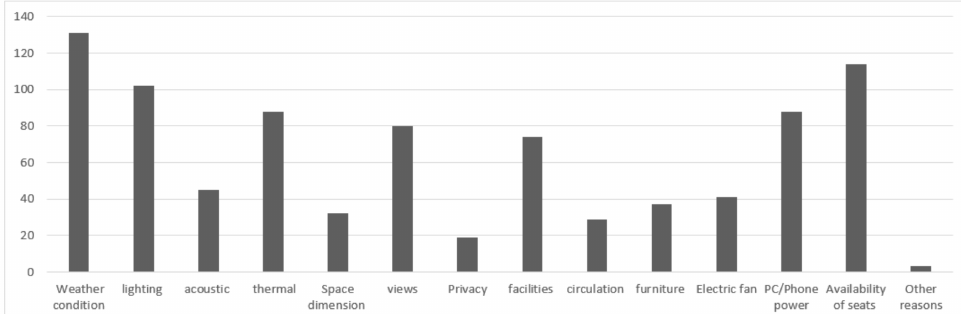
Figure 4. The number of people influenced by various factors affecting user seat